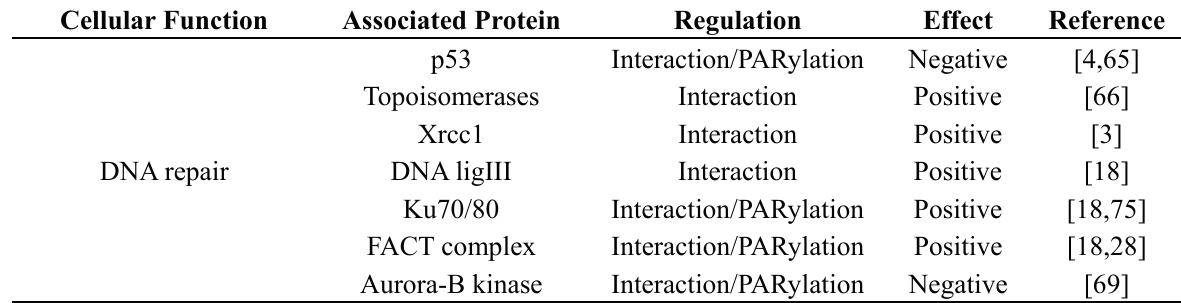
Table 1. Summary of PARP1-mediacted cellular